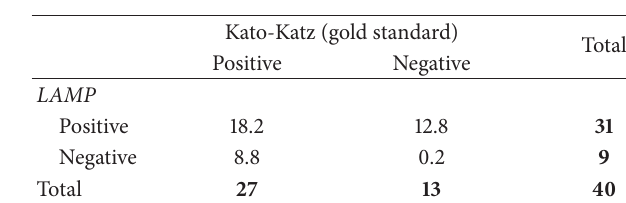
Table 4: Agreement expected by chance alone of LAMP and Kato- Katz